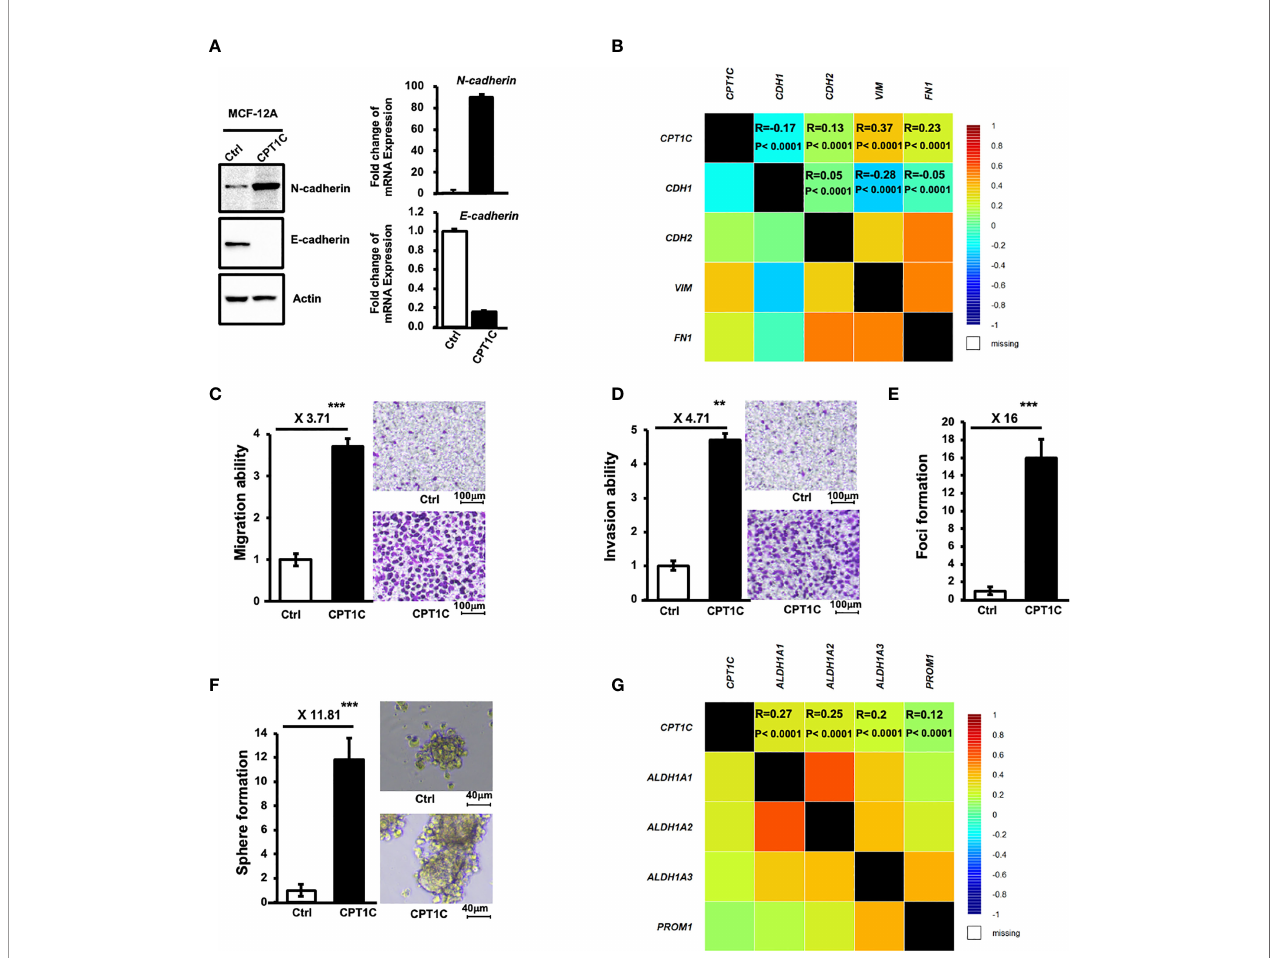
FIGURE 3 | CPT1C induces EMT and enhances migration, invasion, and stemness in mammary epithelial cells. (A) Ectopic expression of CPT1C induces EMT in mammary epithelial cells. The expressional levels of N-Cadherin, E-Cadherin, and Actin in control (Ctrl) and CPT1C-overexpressing (CPT1C) MCF12A cells were examined by Western Blotting. Relative mRNA expression of N-cadherin and E-cadherin between control cells and CPT1C-overexpressing (CPT1C) MCF12A cells were determined by Q-PCR (mean ± SD, n = 3). (B) CPT1C shows a slight to moderate positive association with EMT in breast cancer patients. Correlation map showing the Pearson ’ s pairwise correlations among CPT1C, CDH1 (E-cadherin), CDH2 (N-cadherin), VIN (vimentin), and FN1 ( fi bronectin) in breast cancer patients (N = 4712). Each cell represents a statistical relation between two genes and is colored according to the value of the Pearson correlation coef fi cient ranging from dark blue (coef fi cient = -1) to dark red (coef fi cient = 1). R: correlation coef fi cient value; P: corresponding p-value. Results are derived from bc-GeneExMiner v4.5 (http://bcgenex.ico.unicancer.fr). (C, D) Ectopic expression of CPT1C enhances cell migration (C) and invasion (D) Migration and invasion ability of CPT1C- overexpressing MCF12A cells were analyzed by migration and invasion assay. The relative migration/invasion ability is presented as a fold change of the numbers of cells passed through trans-wells between control and CPT1C groups (mean ± SD; n=3). The two sides of the lines above the bars indicated the comparison of CPT1C-overexpressing cells to the control cells, and the value of fold changes with the asterisks representing signi fi cance was marked above the line. Data were analyzed by unpaired t-test. **p <0.01; ***p < 0.001. Representative micrographs of migrated (C) or invaded (D) cells were shown on the right. (E) CPT1C overexpression enhances anchorage-independent growth. A soft-agar foci formation assay was performed to determine the anchorage-independent growth ability of CPT1C-overexpressing MCF12A cells. Foci number in triplicate dishes was counted and presented as fold change between control and CPT1C groups (mean ± SD; n = 3). The two sides of the line above the bars indicated the comparison of CPT1C-overexpressing cells to the control cells, and the value of fold changes with the asterisks representing signi fi cance was marked above the line. Data were analyzed by unpaired t-test. ***: p < 0.001. (F) Overexpression of CPT1C enhances stemness. CPT1C-overexpressing MCF12A cells exhibit higher mammosphere forming ability. Control or CPT1C-overexpressing MCF12A cells were grown in suspension culture for 7-8 days to form mammospheres. Mammospheres with a diameter larger than 40 m m were counted and presented as fold change. Results were derived from experiments done in triplicate (mean ± SD; n = 3). The two sides of the line above the bars indicated the comparison of CPT1C-overexpressing cells to the control cells, and the value of fold changes with the asterisks representing signi fi cance was marked above the line. Data were analyzed by unpaired t-test. ***p < 0.001. Representative micrographs of mammospheres under a microscope are shown on the right. (G) CPT1C shows a slight to moderate positive association with stemness markers in breast cancer patients. Correlation map showing the Pearson ’ s pairwise correlations among CPT1C and stemness